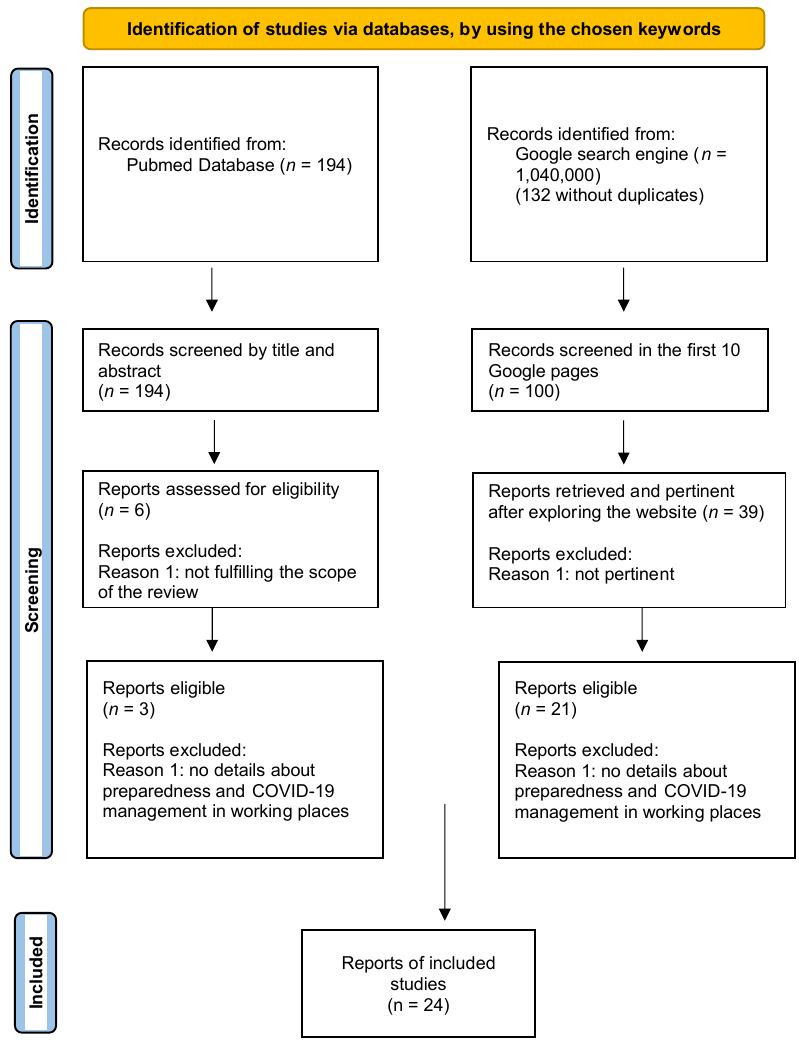
Figure 1. Flowchart showing the search strategy. Model of Flowchart modified from: [14,25].